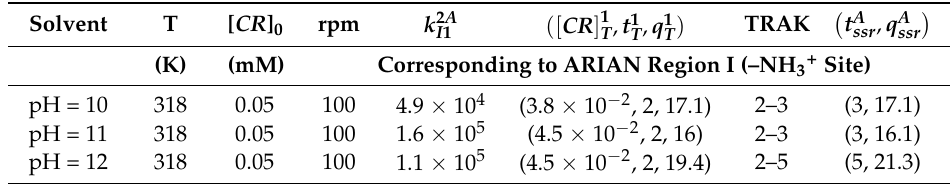
* pH = 11 pH = 13 Unit of k 2 A I , k 2 A I 2 a and k 2 A is in M − 1 · min − 1 and that of t A ssr , t A sp and , t 2 T is in min. Unit of q A ssr , q A sp and q 2 T is in 1 I 2 b mg · g − 1 . Units of [ CR ] 0 and [ CR ] T is in mM. [ CR ] 2 T , t 2 T and q 2 T are CR concentration, time and adsorption capacity at the beginning of the TRAK between region 2 of the first kinetic curve and second kinetic curve, respectively (corresponding to [ CR ] e , t e and q e in the last curve). Superscript of A refers to –NH 3+ site. k 2 A I the rate constants of adsorption on –NH 3 + site in region 1 and region 2 (parts 2a and 2b) of the ISO equation, respectively. * Data of region 1 of the ISO equation have been given in Table 9. Table 9. Coefficients of region 1 of the ISO equation for kinetics of CR adsorption on the –NH 3+ (first available) sites of GO/PAMAM (on the first kinetic curve) at different pH values (from Table 8). Solvent T